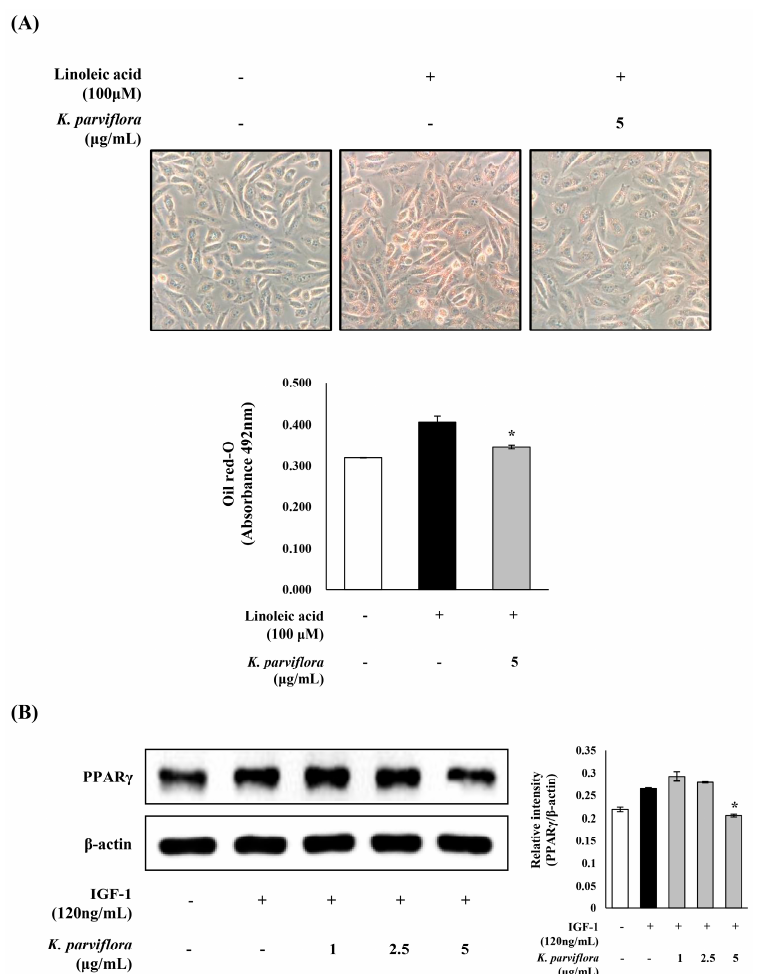
Figure 6. ( A ) Effects of Kaempferia parviflora extract on lipid synthesis in sebocytes. The lipid content of sebocytes was detected by Oil red O staining and then measured by ELISA. The sebocytes were shown by microscopy at a magnification of × 100; ( B ) effects of K. parviflora extract on the expression of IGF-1-induced peroxisome proliferator-activated receptor gamma (PPAR- γ ). The expressions of PPAR- γ was analyzed with ImageJ and normalized against β -actin. All data are expressed as mean ± SD. * p < 0.05 compared to IGF-1 or linoleic acid treated cells only.